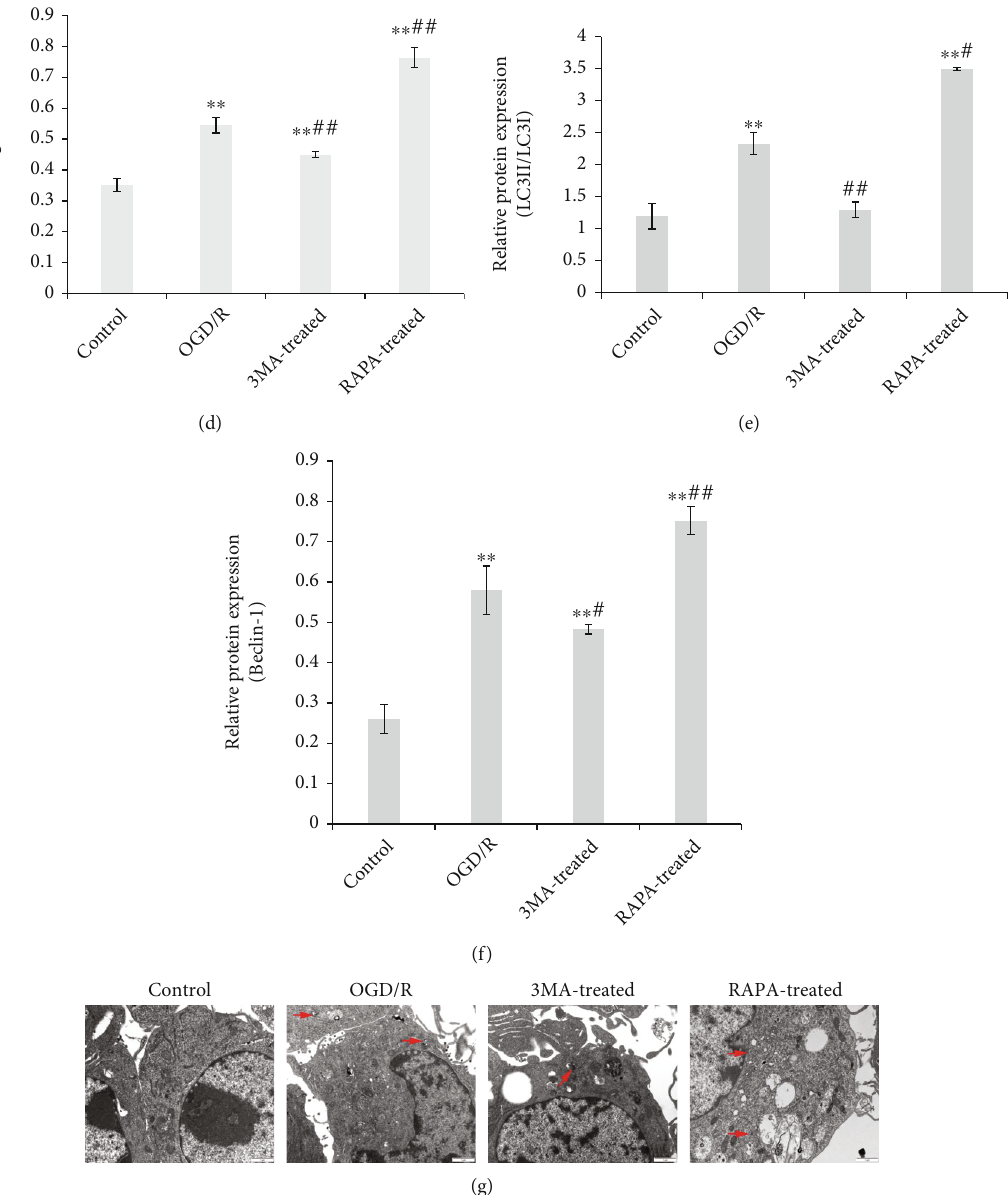
Figure 1: The relation of oxidative stress and autophagy in microglia. The ROS level, autophagy-related proteins, and autophagolysosomes were measured in microglia and OGD/R-induced microglia, and the autophagy inhibitor 3MA and autophagy agonist RAPA were involved. (a, b) ROS level was detected using fl ow cytometry. (c) Autophagy-related proteins were detected using western blotting including Atg5 (d), LC3I/II (e), and Beclin-1 (f). (g) Autophagolysosomes (red arrow) were observed using transmission electron microscope. The data was given as mean ± SD , n = 3 . ∗∗ p < 0 : 01 compared with microglia in culture (control). # p < 0 : 05 and ## p < 0 : 01 compared with microglia on glucose depreciation/reoxygenation (OGD/R) culture condition